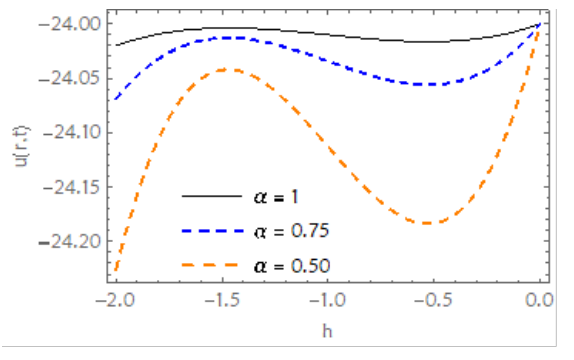
Fig. 10: h -curve of solution u ( r , t ) Vs. (cid:126) obtained when t = 0.01, r = 1, n = 1, for Ex. 4.2